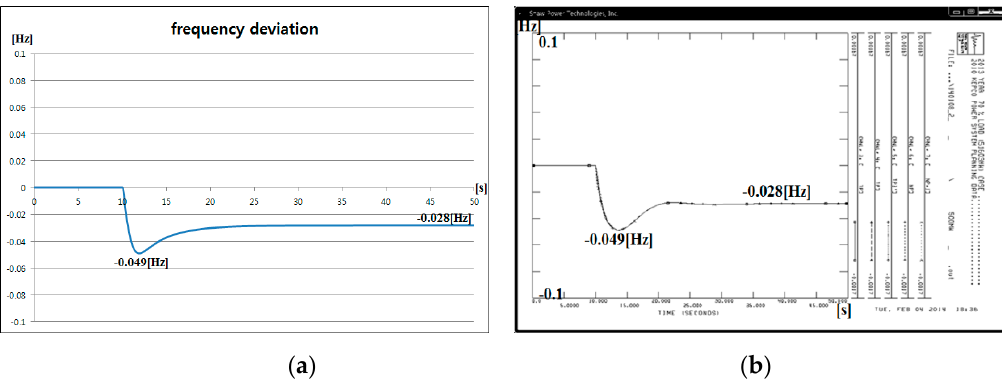
Figure 9. The frequency characteristic of grid-connected system: ( a ) Results of the AGC Program; ( b ) Results of PSS/E.